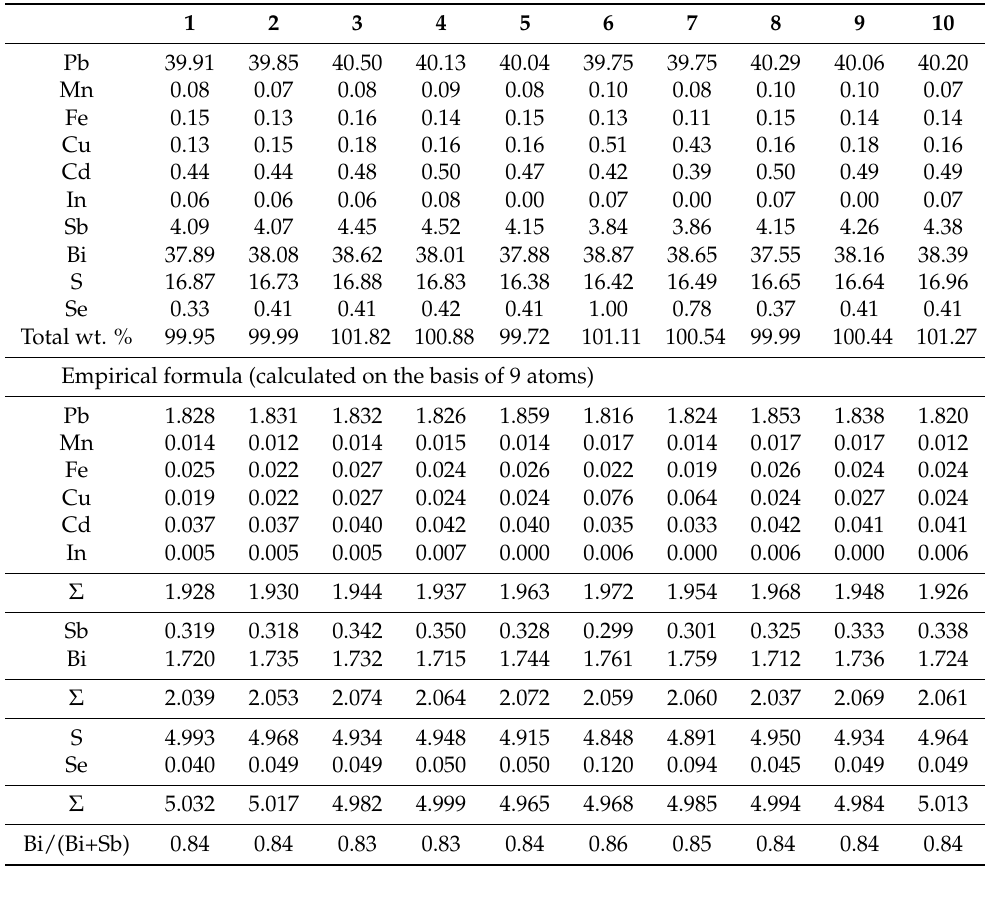
Table 11. Representative WDS microanalyses of cosalite from ˇCuˇcma (Majersk á valley).